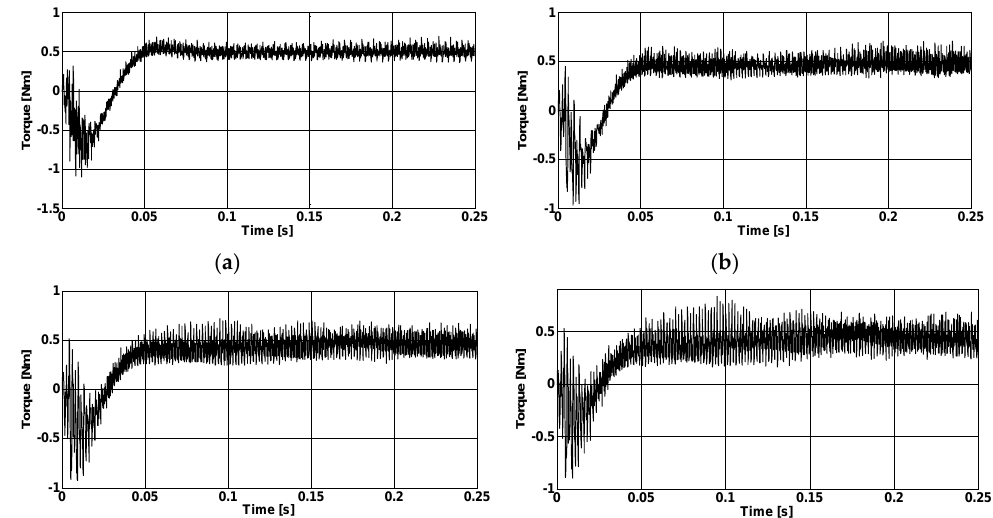
Figure 12. Variation of the torque vs. time in the starting process of the ZAIM for different values of the eccentricity: ( a ) e = 0 mm; ( b ) e = 0.5 mm; ( c ) e = 1 mm; ( d ) e = 1.5 mm.